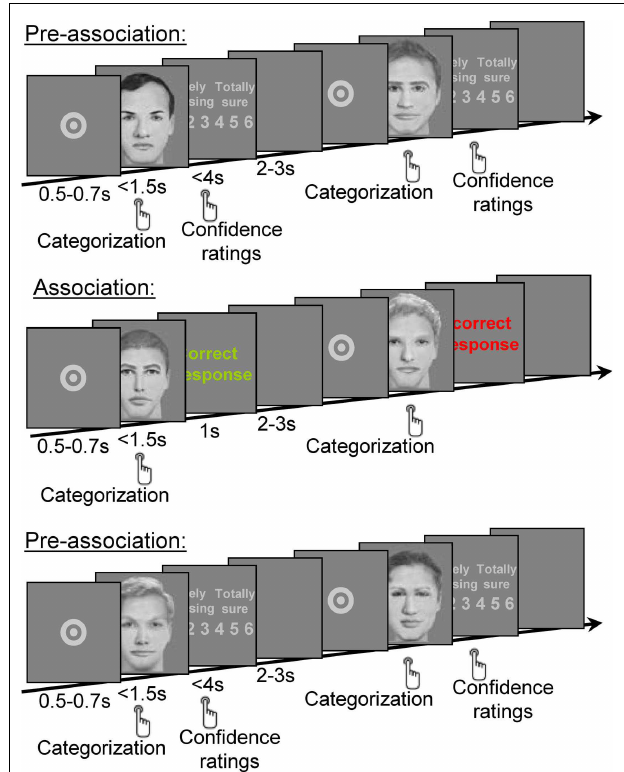
FIGURE 1 | Experiment 1, experimental design. Each trial started with a central fixation point (presented for 0.5–0.7s), followed by a face that subjects had to categorize as flexible or determined as quickly as possible and before the face disappearance.The face remained on-screen until subjects’ response or for up to 1.5s. In both the pre- and post-association phases, a confidence rating screen was then presented. Subjects had to rate the confidence they had in their personality judgment between one (random guess) to six (absolutely sure). Inter-trial interval was initiated by subjects’ response or after up to 4s. In the association phase, there was no confidence rating after the categorization response but subjects were given a 1s feedback on the accuracy of this response. Unknown to the subject, the feedback was based on the inter-eye distance of the face presented. There was no stimulus repetition across the successive phases of the study; every face and every face feature (including the eyes) were new for each